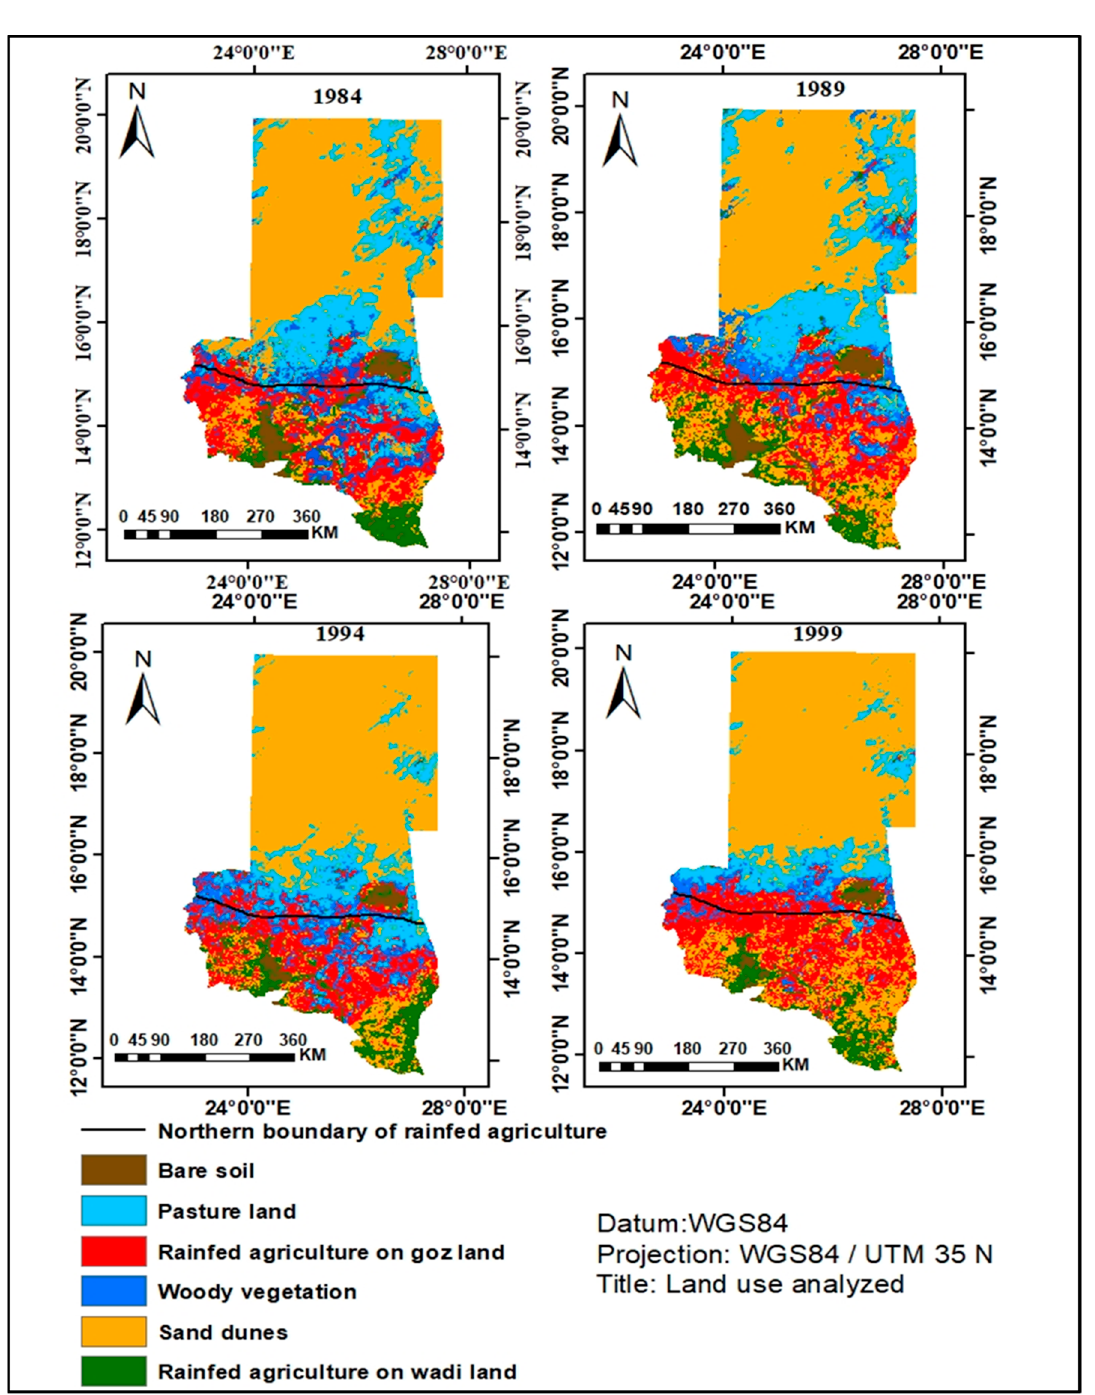
Figure 2. Spatial distribution of the rainfed agriculture and other LULC classes in 1984, 1989, 1994 and 1999. The classification was obtained using Landsat-5 MSS, Landsat-5TM, and random forest classifier.